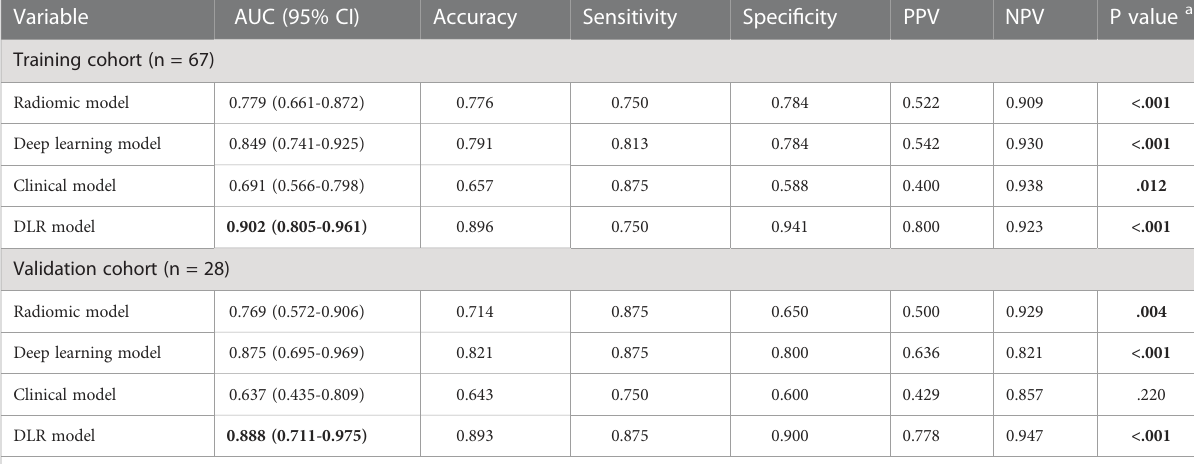
TABLE 3 Performance of early treatment image-based radiomics, deep learning, clinical and DLR models. Variable AUC (95% CI) Accuracy Sensitivity Speci fi city PPV NPV P value